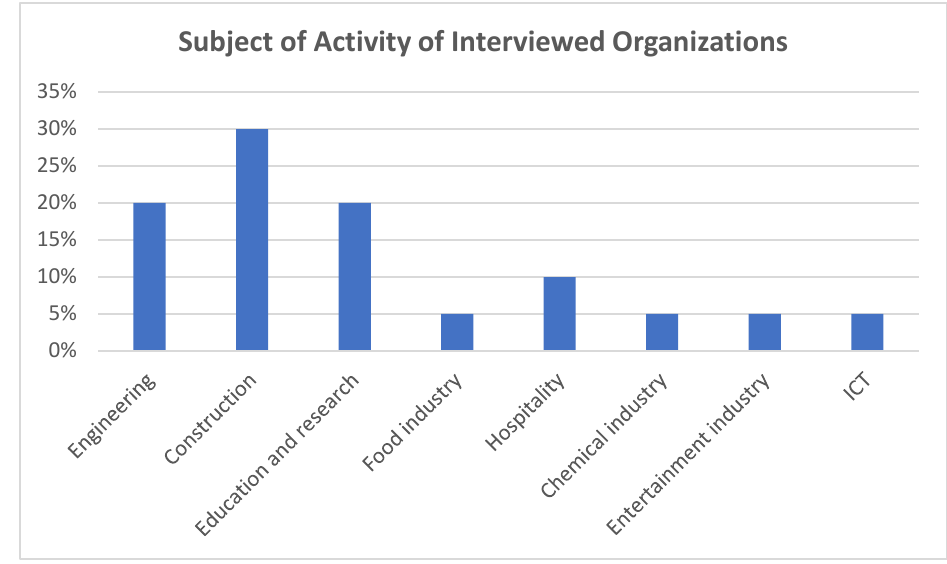
Figure 1. Subject of activity of interviewed organizations (own resource).